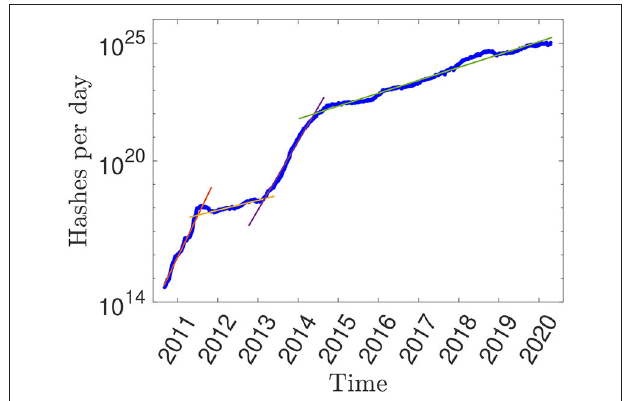
FIGURE 2 | Daily hashes computed by the Bitcoin network. The lines are best-fits with exponential growth laws in the corresponding sub-periods. Doubling times are respectively (i) 33 days, during mid 2010 to mid 2011; (ii) 261 days, during mid 2011 to early 2013; (iii) 38 days during early 2013 to early 2015; (iv) 198 days, during early 2015 to early 2020.